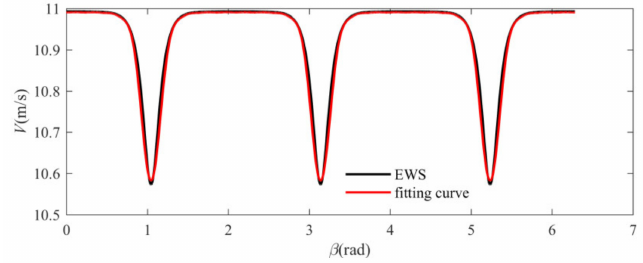
Figure 3. Original equivalent wind speed curve and the fitting